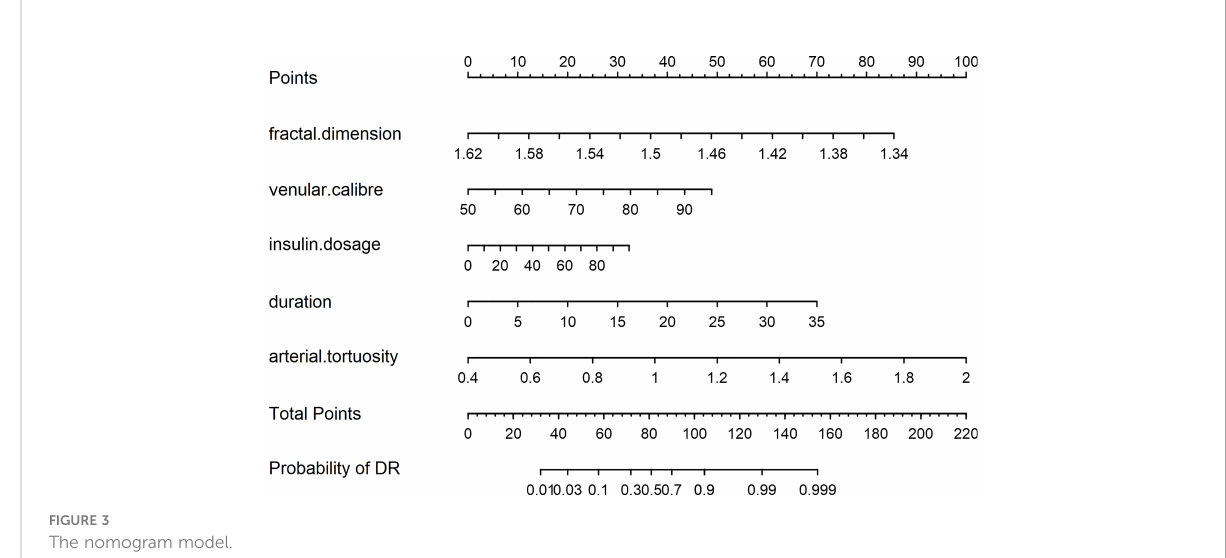
FIGURE 3 The nomogram model.